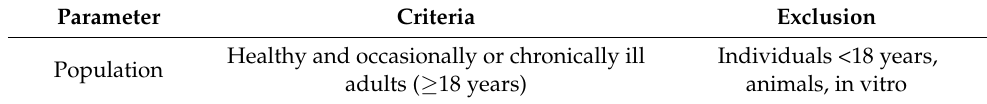
Table 2. PICOS criteria for inclusion and exclusion of studies.